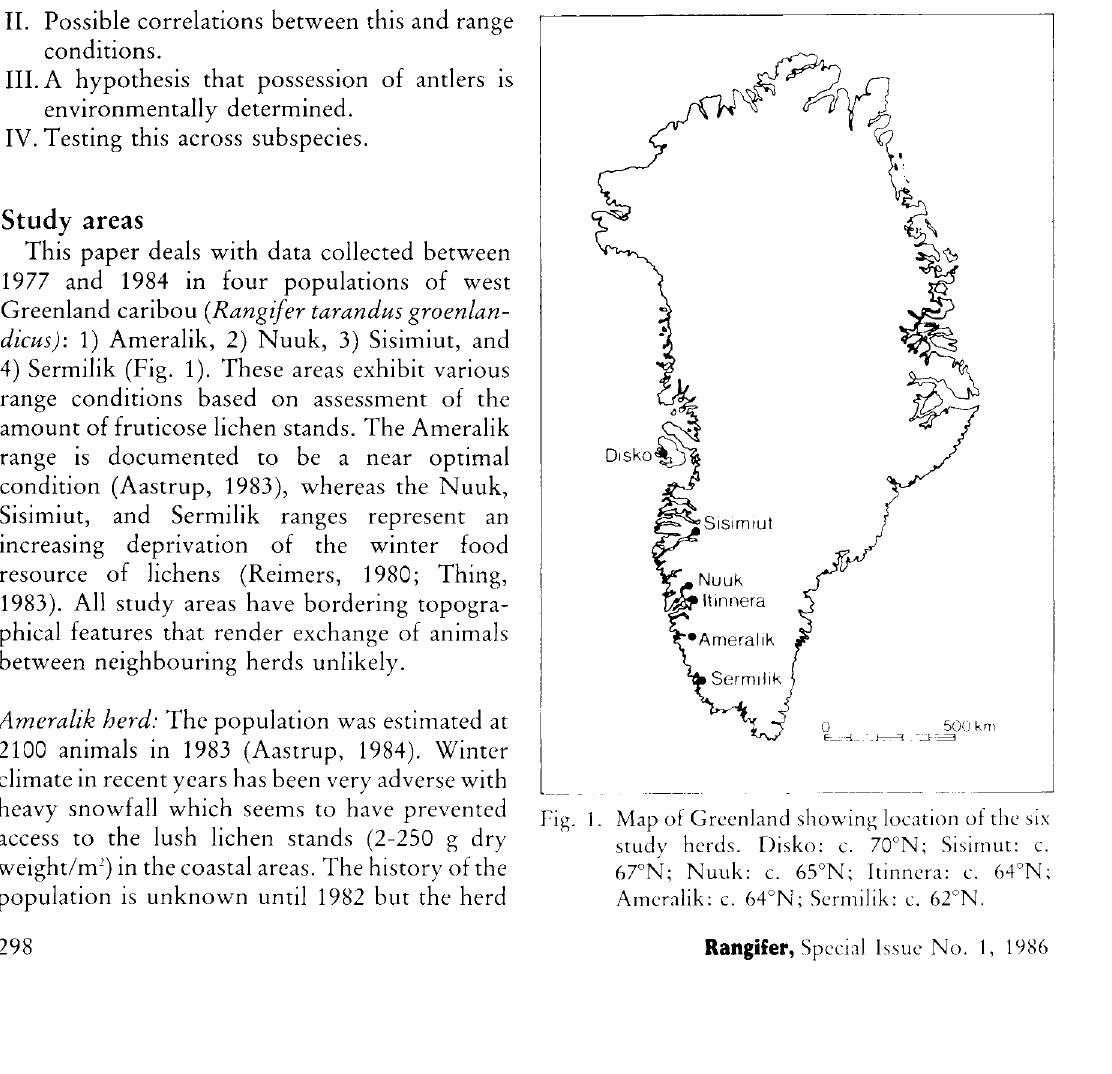
Fig. 1. Map of Greenland showing location of the six study herds. Disko: c. 70°N; Sisimut: